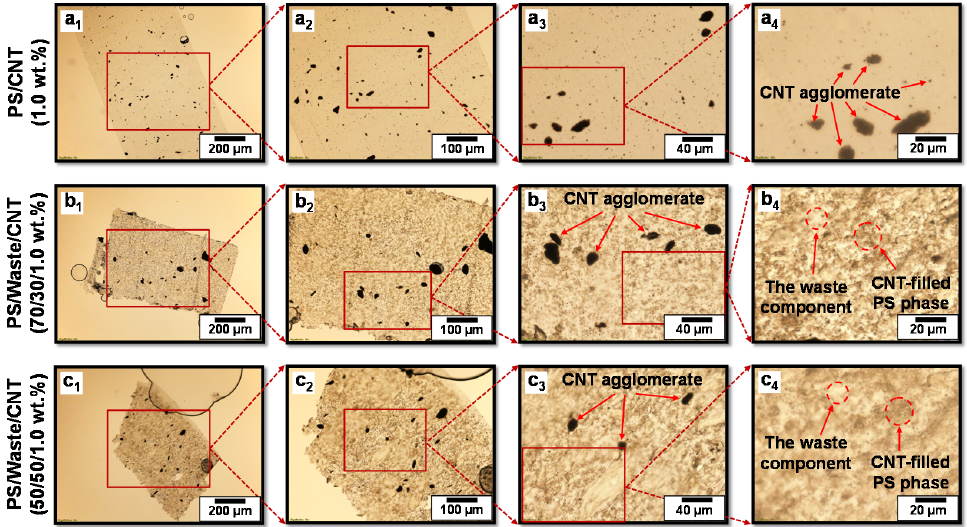
Figure 1. Optical microscopy images of ( a 1 – a 4 ) PS/CNT (1.0 wt.%), ( b 1 – b 4 ) PS/Waste/CNT (70/30/1.0 wt.%), and ( c 1 – c 4 ) PS/Waste/CNT (50/50/1.0 wt.%) nanocomposites at different magnifi- cation.